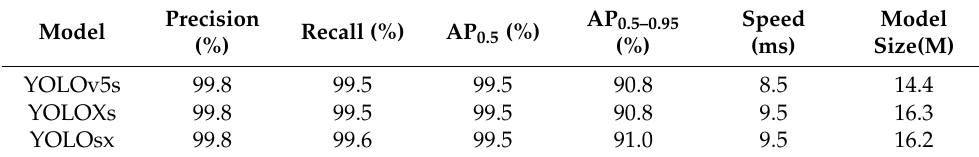
Table 3. Results of YOLOv5s, YOLOxs, and YOLOsx in position detection. Model